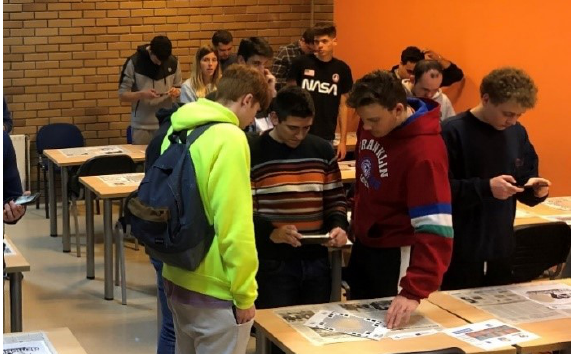
Figure 3. Students practising 3-D scanning with mobile apps